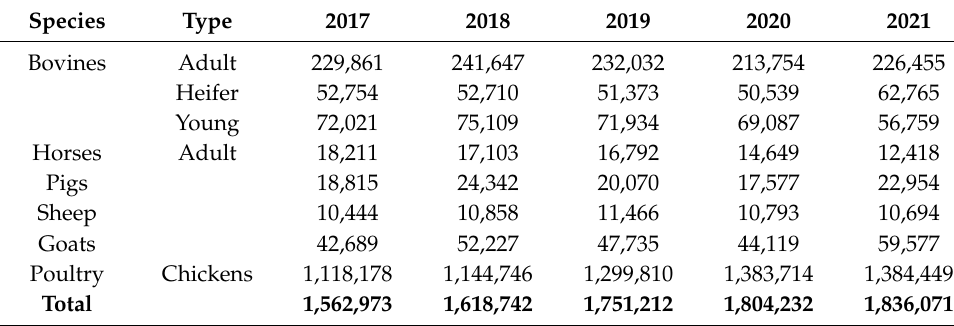
Table 2. Livestock populations in Bhutan by animal species and type. Species